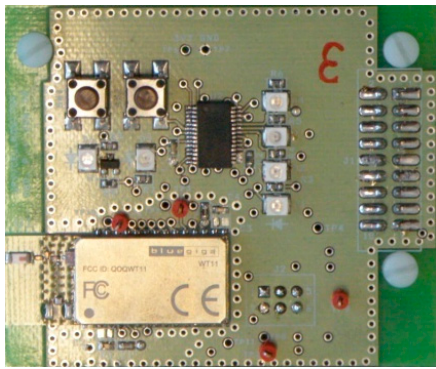
Figure 2. Photography of one of the implemented Bluetooth nodes.